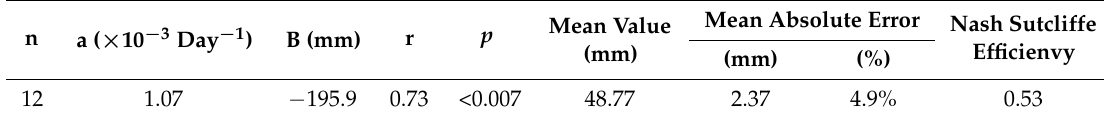
Table 1. Baseflow model calibrations and performance